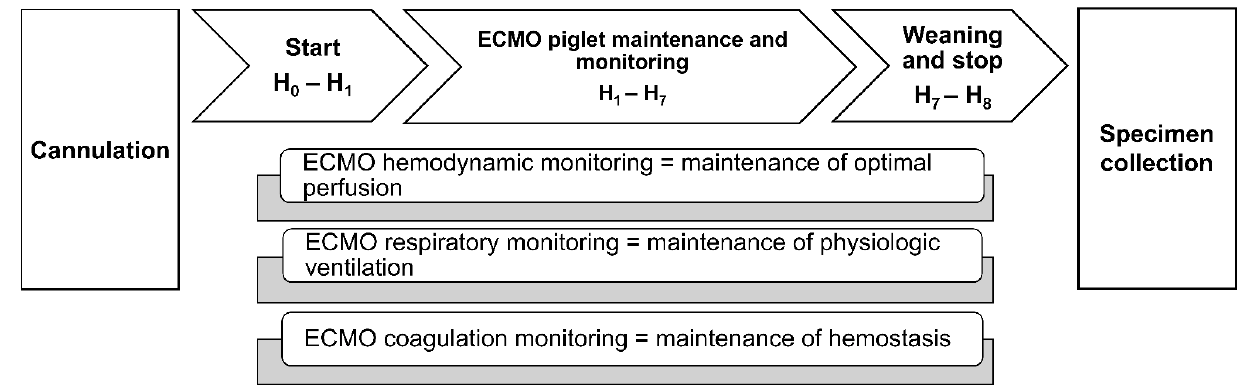
Figure 2. Extracorporeal membrane oxygenation (ECMO) timeline. Schematic representation of ECMO procedure’s steps and monitored parameters.